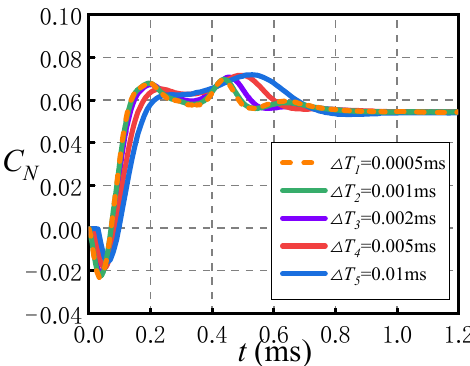
Figure 7. The variation of normal force coefficient calculated by different time steps. ( Ma = 2.5, (cid:2009) = ◦ , PR = 0°, PR = 100). α = 0